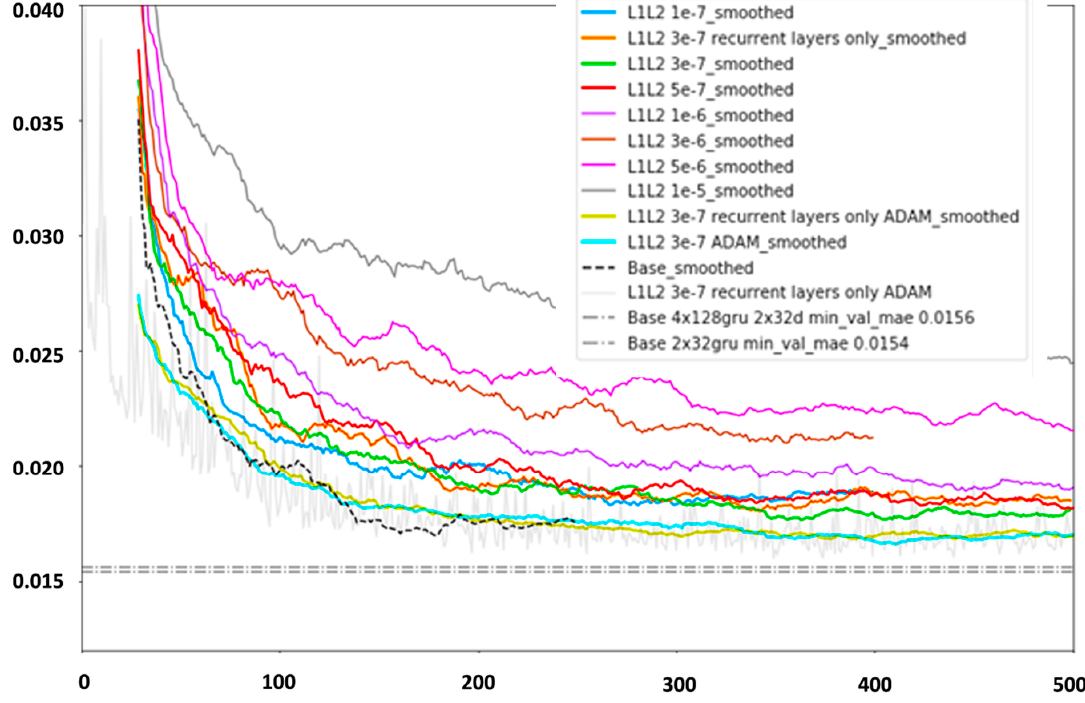
Figure 12. Deepest model (4 × 128 GRU, 2 × 32 FF) with weights regularization.